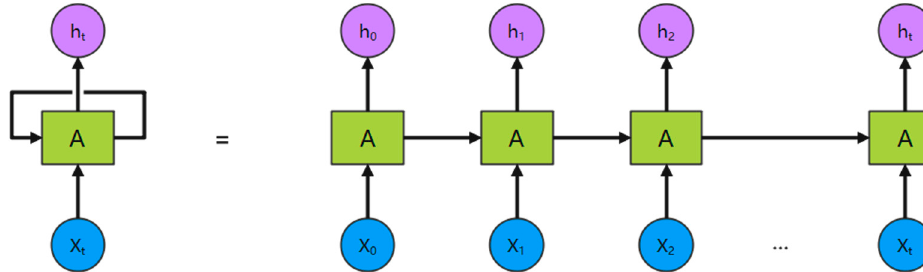
Figure 4. RNN chain structure.